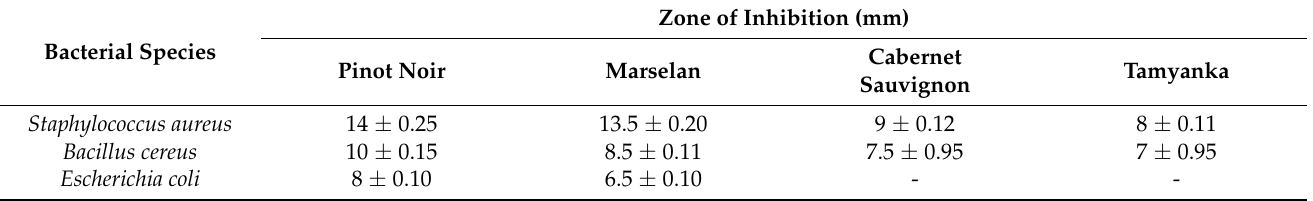
Table 5. Effect of grape seed extracts on the growth of pathogenic